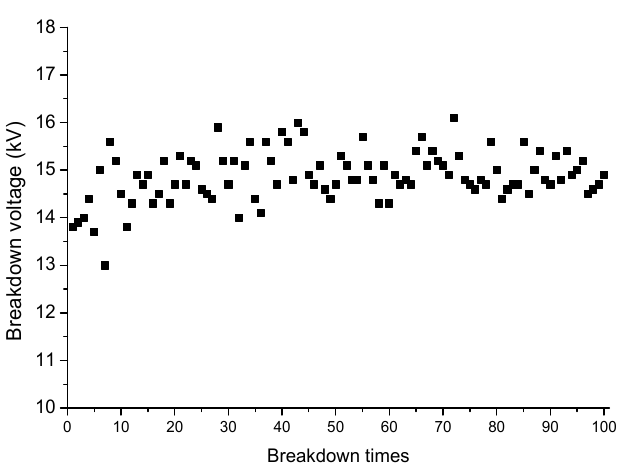
Figure 2. Breakdown voltage of the C 6 F 12 O/N 2 mixed gas.